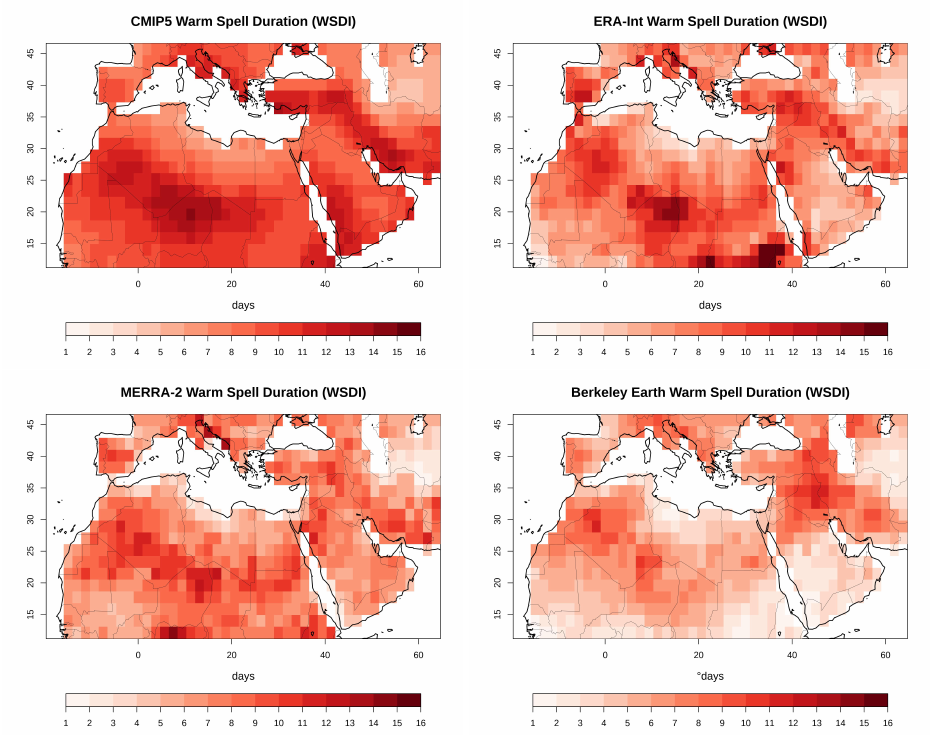
Figure 3. 1980–2018 climatology of the Warm Spell Duration (WSDI) for the: CMIP5 multi-model ensemble mean ( top left ), ERA-Interim ( top right ), MERRA-2 ( bottom left ), and Berkeley Earth ( bottom right